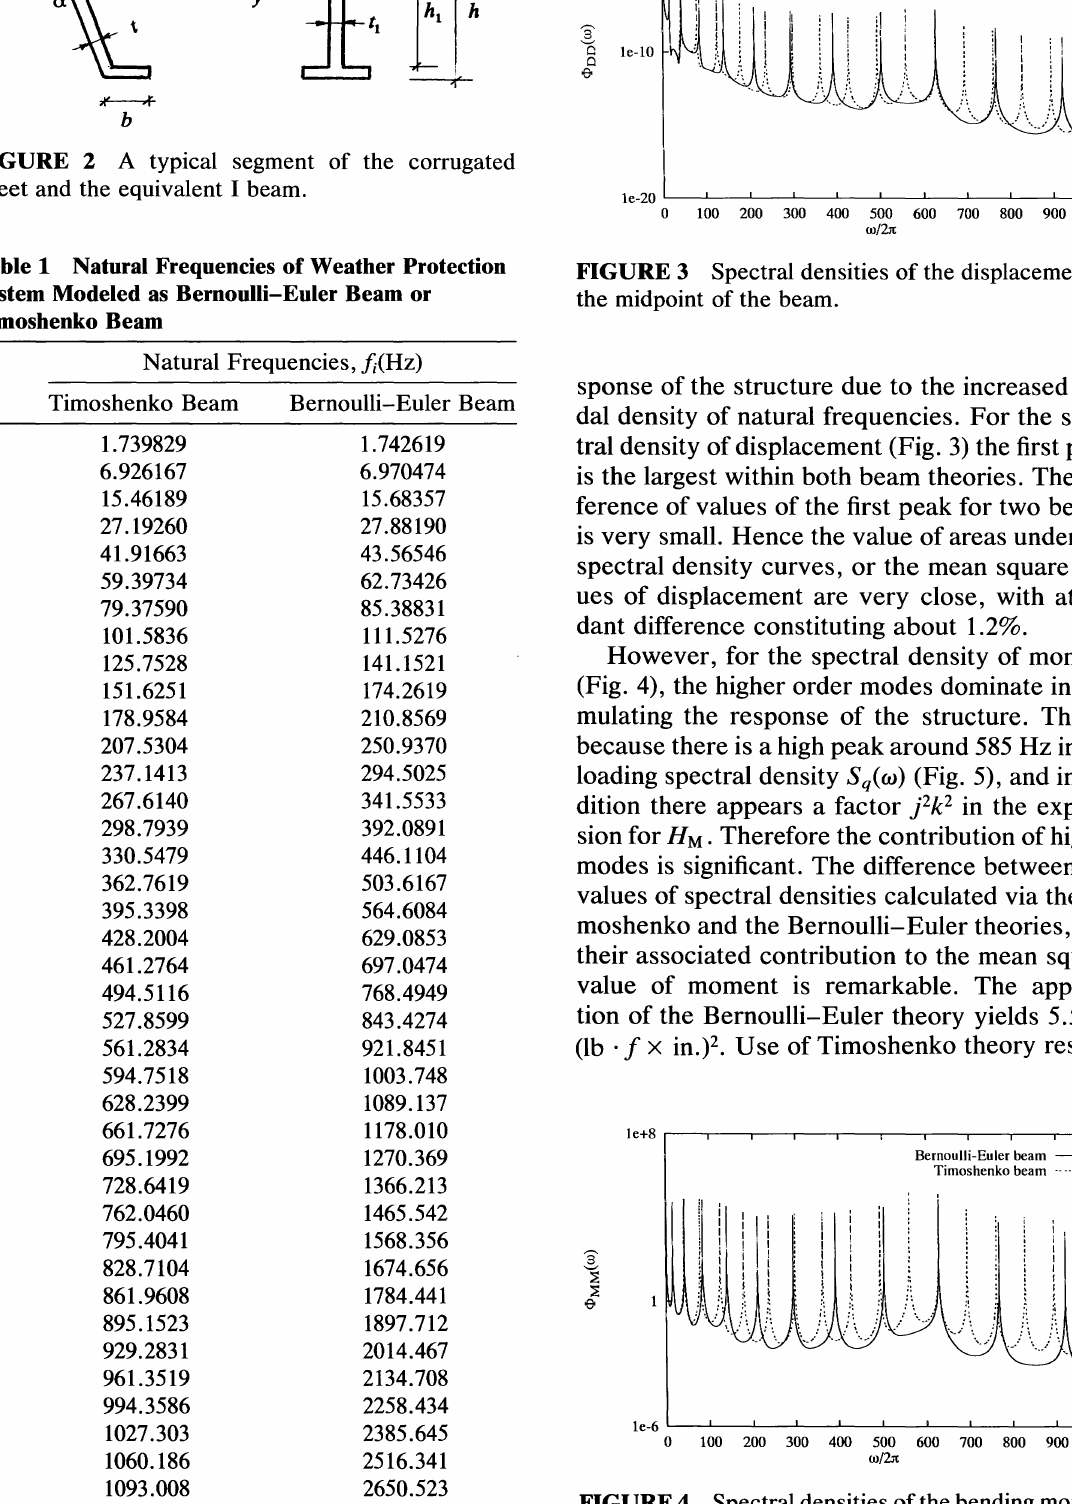
FIGURE 2 A typical segment of the corrugated sheet and the equivalent I beam. Table 1 Natural Frequencies of Weather Protection System Modeled as Bernoulli-Euler Beam or